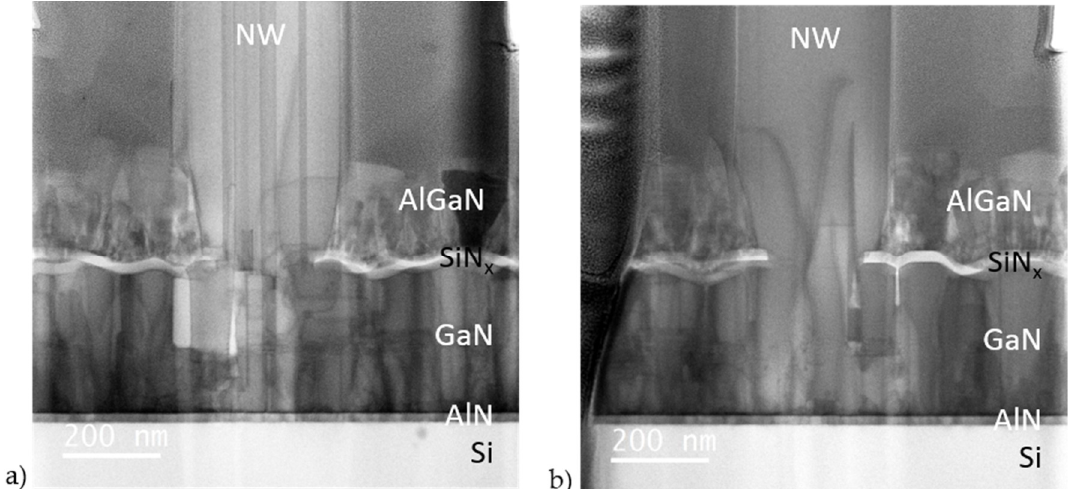
Figure 2. STEM ABF images of NWs on sample N–AlGaSL-1 showing: ( a ) inversion domains, some of which propagate from the GaN buffer and some of which initiate at the regrowth interface; ( b ) threading dislocations propagating from the GaN buffer into the NW and annihilating near the NW base. After the NW growth, an AlGaN layer was deposited on this sample at low a temperature and can be seen on the SiNx buffer in both images.